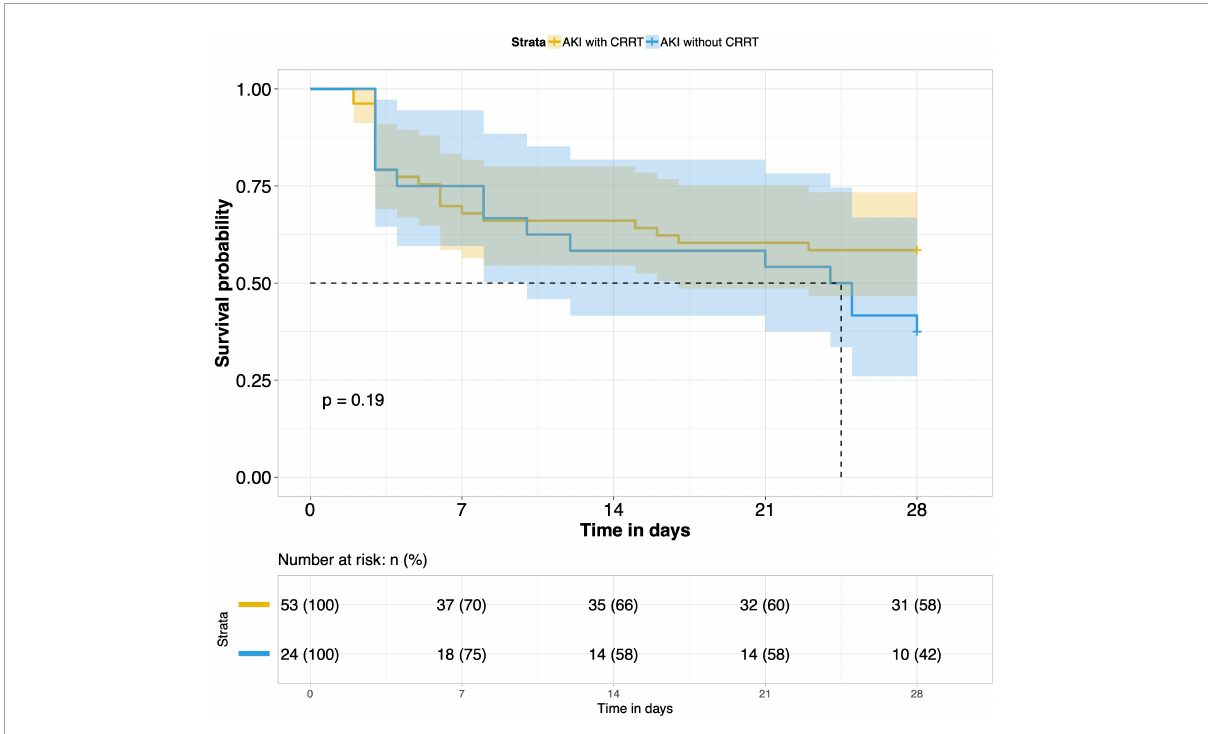
FIGURE9 Survival analysis of AKI with CRRT and AKI without